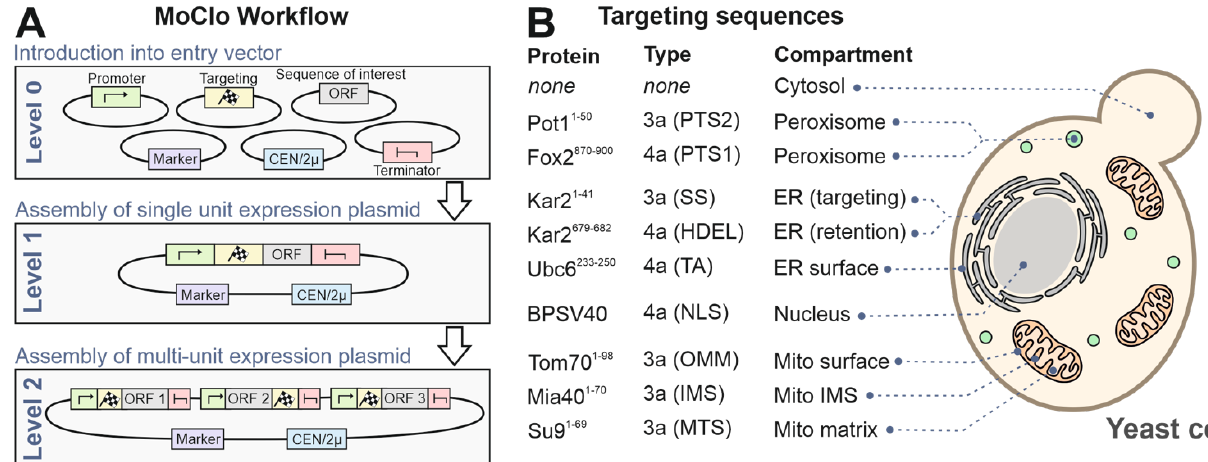
FIGURE 2: A modular cloning workflow with sequence cassettes for intracellular protein targeting. (A) The defined syntax of the MoClo workflow allows the combination of sequence parts into expression plasmids. (B) Overview of the targeting sequences used in this study. The type designates the part according to the nomenclature used in a previous study [14]. TA, tail anchor of Ubc6. SS, signal sequence. OMM, outer mitochondrial membrane. See Materials and Methods for